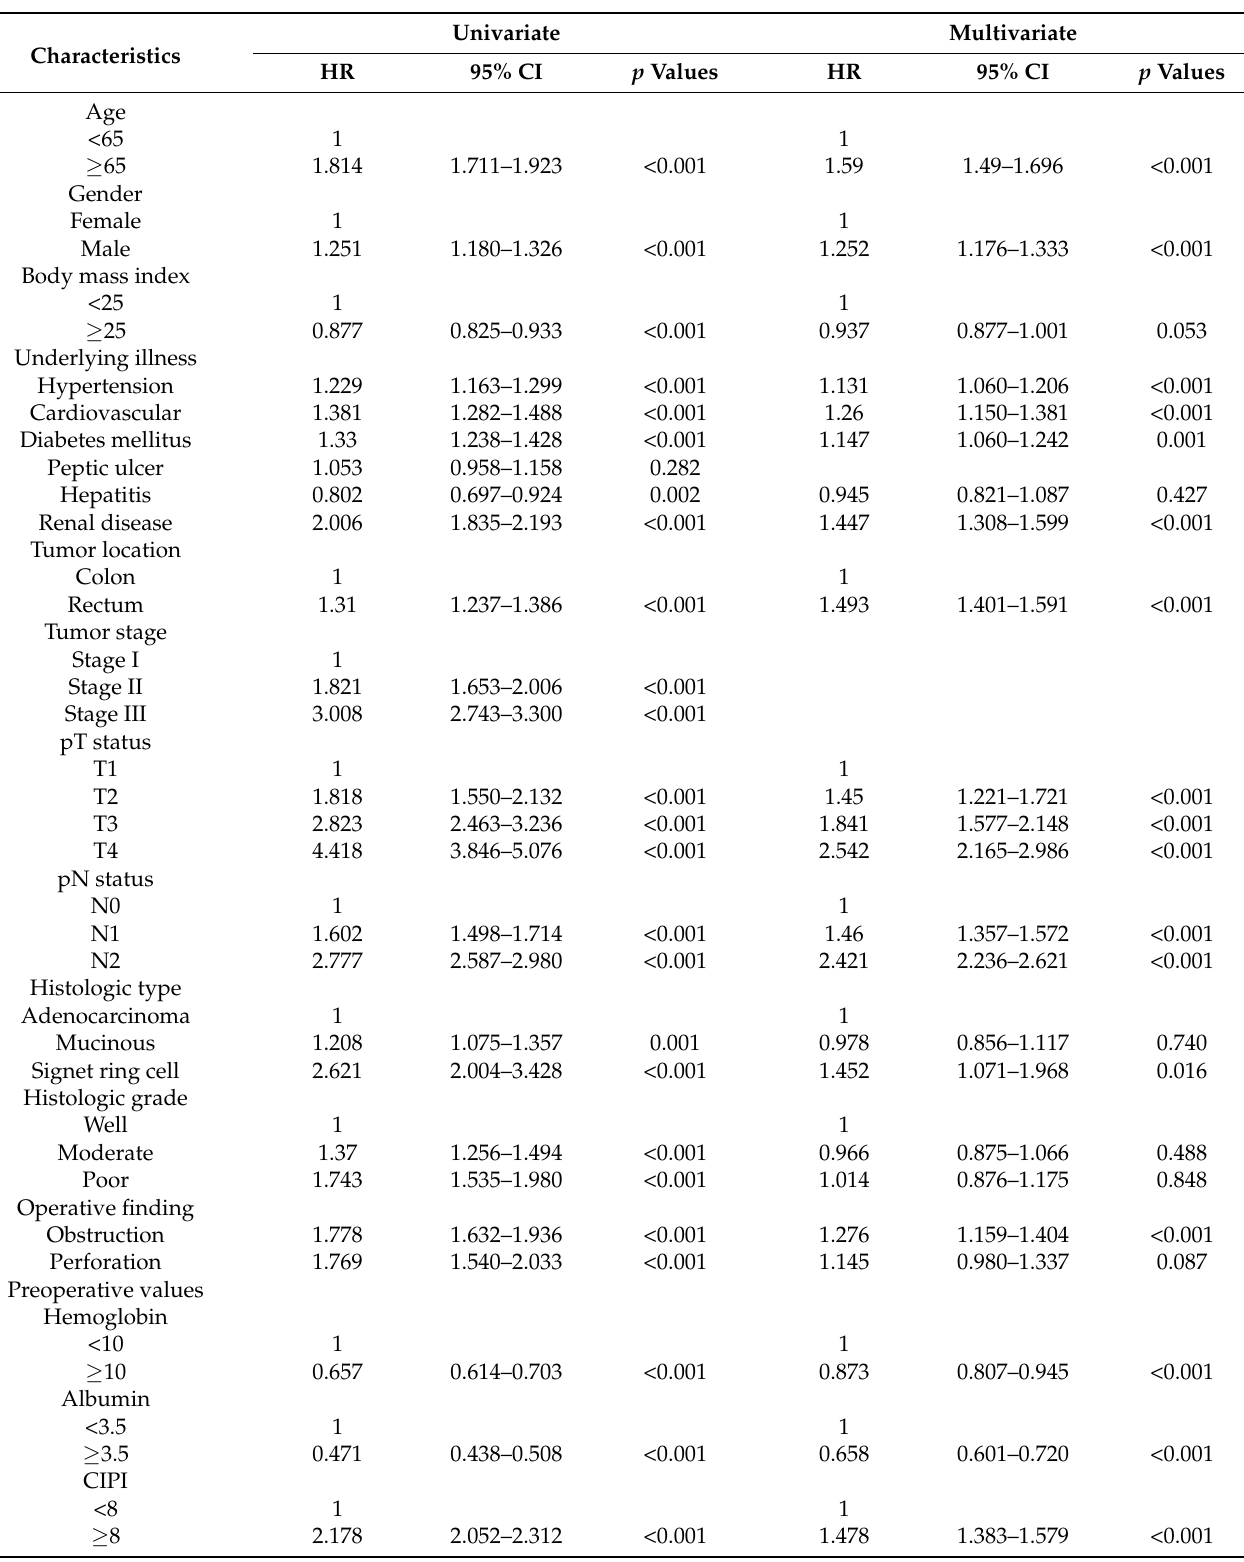
Table 3. Univariate and multivariate Cox proportional hazards regression analyses of prognostic factors for relapse-free